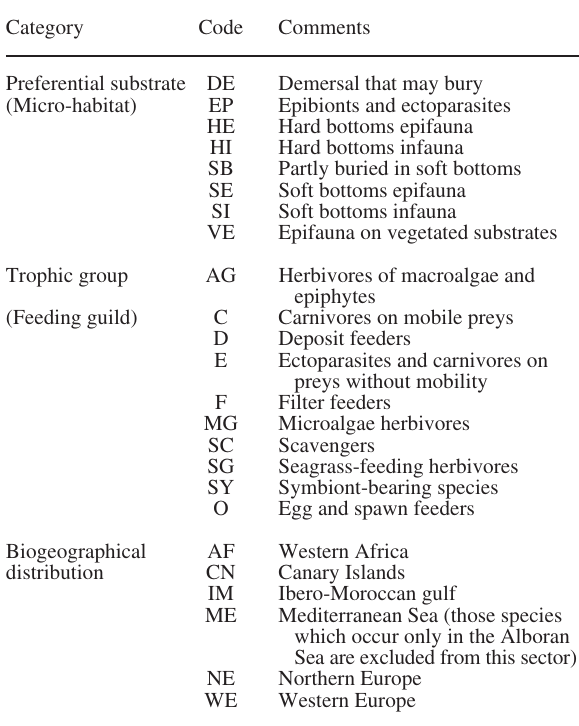
Table 1. – List and meaning of codes used in the characterisation of the species in relation to their micro-habitat preference, feeding guild and biogeographical